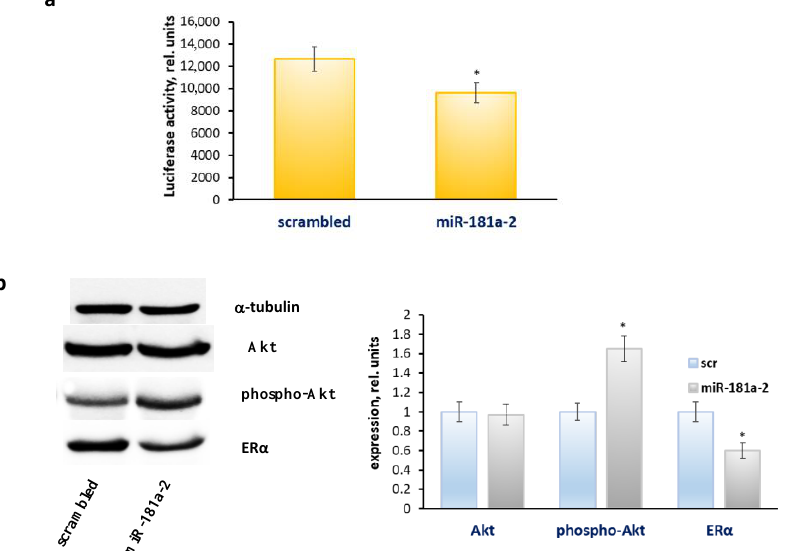
Figure 3. The effect of the multiple transfections of miR-181a-2 on the ER α transcriptional activity and protein profile. The MCF7 cells were cultured for two months after multiple transfections with miR-181a-2-mimetic or scrambled-RNA construct, then the cells were transfected with the ERE plasmid containing the luciferase reporter gene under the oestrogen-responsive element (ERE) and β -galactosidase plasmid ( a ). The relative luciferase activity was calculated in arbitrary units as the ratio of the luciferase to the galactosidase activity. Data represent the mean value ± SD of three independent experiments. The viability of cells treated with vehicle control was set at 100%. ( b ) Western blot analysis. The MCF7 cells were treated as indicated above. Western blot analysis of Akt, phospho-Akt and ER α was performed in the MCF7 cell extracts. Protein loading was controlled by membrane hybridization with α -tubulin antibodies. Densitometry for immunoblotting data (right diagram) was carried out using ImageJ software; * p < 0.05 versus scrambled